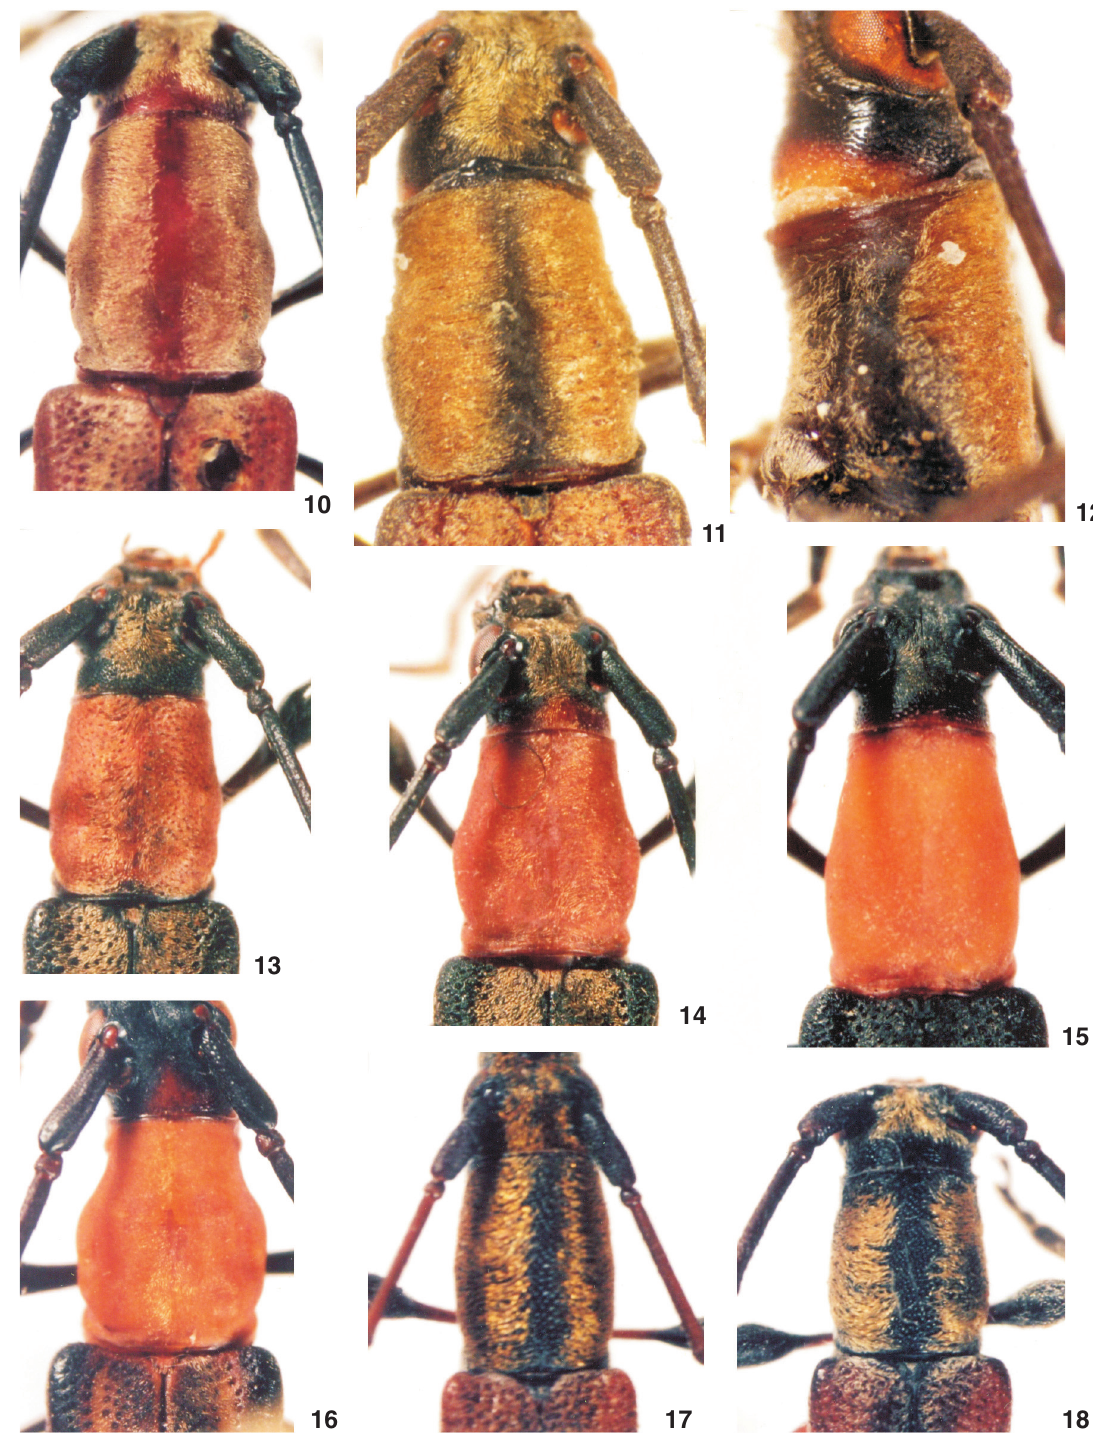
Figuras 10-18. Protórax: (10) R . pulverulenta ; (11-12) R . venezuelensis ; (13) R . prolixa ; (14) R . occipitalis ; (15) R . paraensis ; (16) R . collaris ; (17) R . casignata ; (18) R . dyseidia ZOOLOGIA 26 (2): 343–356, June, 2009